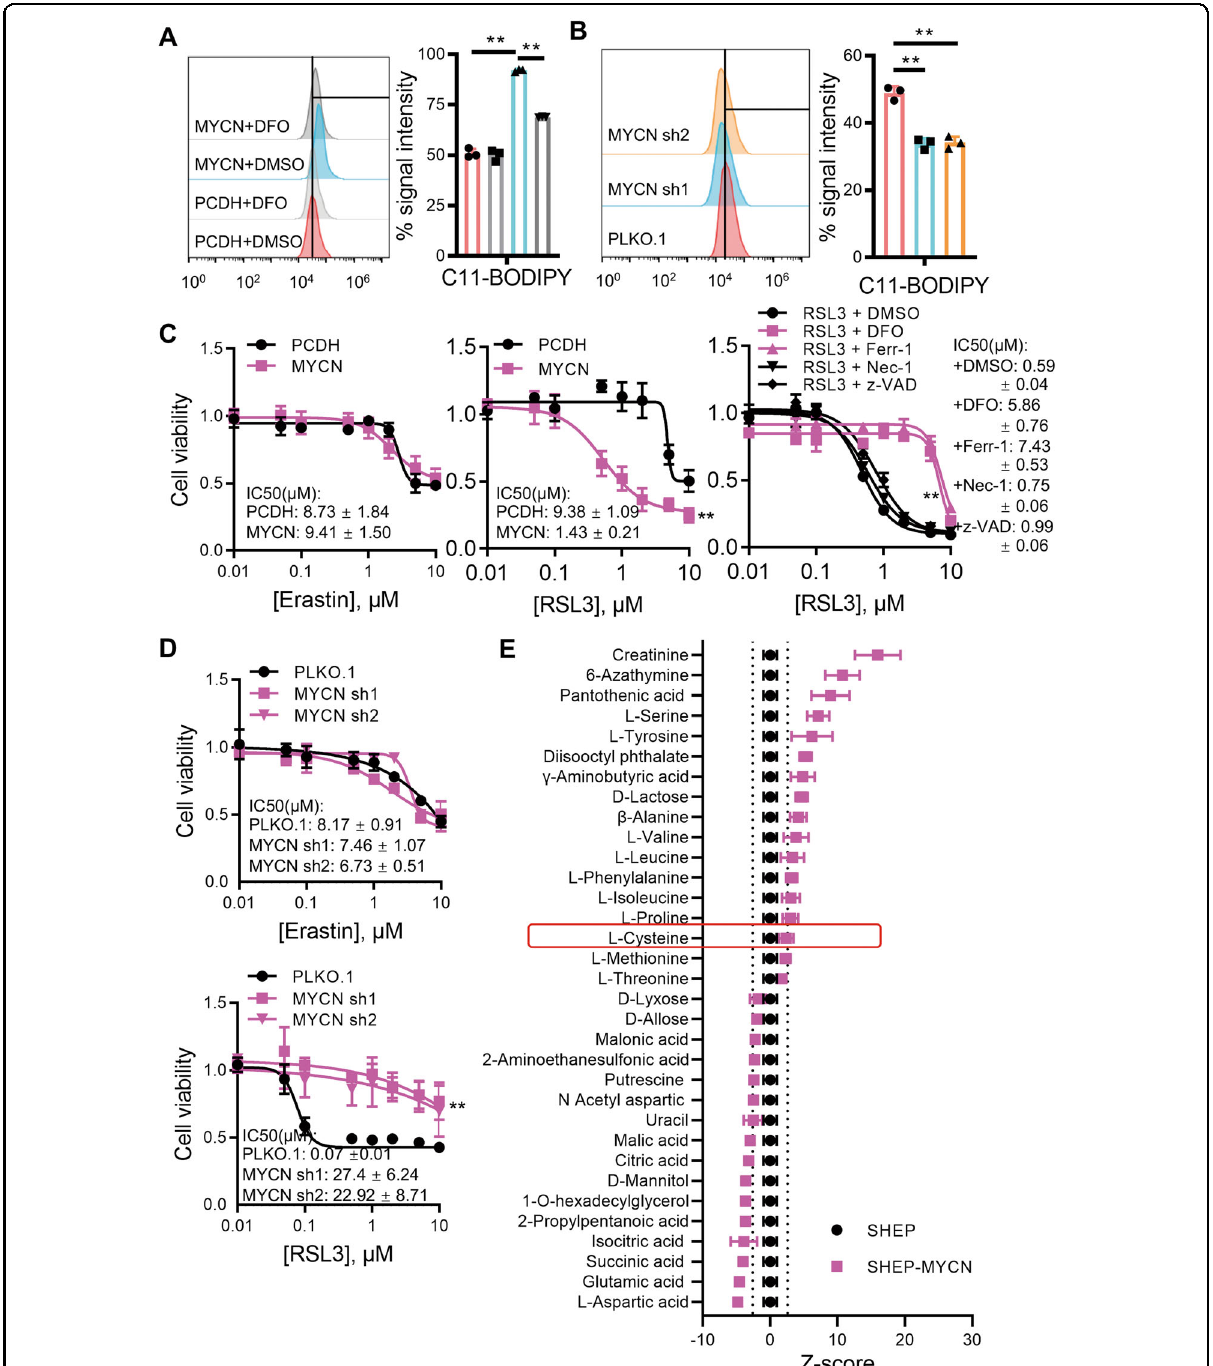
Fig. 2 MYCN confers cell sensitivity to ferroptosis upon GPX4 inhibition. Lipid peroxides were detected by fl ow cytometry after incubation with C11-BODIPY in SHEP ( A ) or SK-N-BE2 ( B ) cells with or without MYCN . DFO, desferrioxamine, n = 3. C Cell viabilities of SHEP cells with or without MYCN overexpression incubated with Erastin (left), RSL3 (middle), or RSL3 combined with either ferroptosis inhibitor (10 μ M DFO, 1 μ M Ferr-1), apoptosis inhibitor (20 μ M z-VAD), or necroptosis inhibitor (2 μ M Necrostatin-1) (right). D Cell viabilities of SK-N-BE2 cells with or without MYCN knockdown incubated with Erastin or RSL3. E Metabolic analysis of SHEP cells with or without MYCN . Z-score ±2.75 is corresponding to p = 0.01 and depicted as a dotted line. Data are presented as mean ± SD of three replicates. Two-tailed unpaired t -tests were performed to calculate p values. ** p <